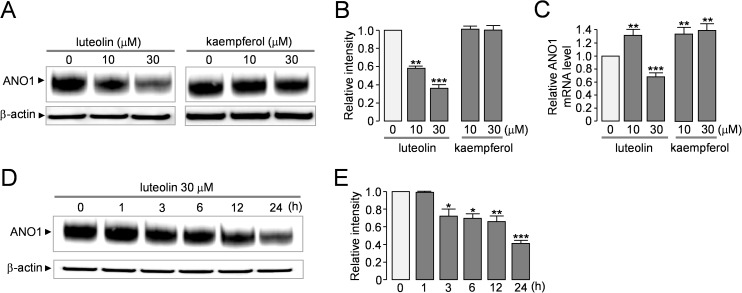
Effect of luteolin and kaempferol on the expression levels of ANO1 in PC-3 cells.A) Immunoblot analysis of ANO1 in PC-3 cells expressing high levels of ANO1. Cells were incubated with indicated concentration of luteolin and kaempferol for 24 hour. B) The ANO1 band intensity was normalized to β-actin (mean ± S.E., n = 3–4). C) Effect of luteolin and kaempferol on gene expression levels of ANO1 in the PC-3 cells (mean ± S.E., n = 3). D) Luteolin-induced time-dependent changes of ANO1 protein levels in the PC-3 cells. E) The ANO1 band intensity was normalized to β-actin (mean ± S.E., n = 3). *P < 0.05, **P < 0.01, ***P < 0.001.